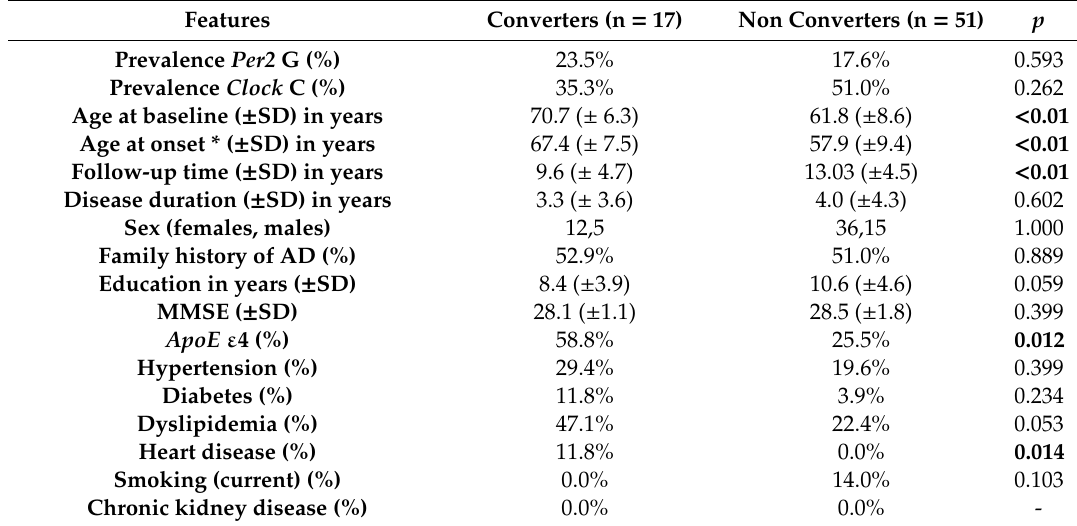
Table 3. Comparison of demographic and clinical data between converters and